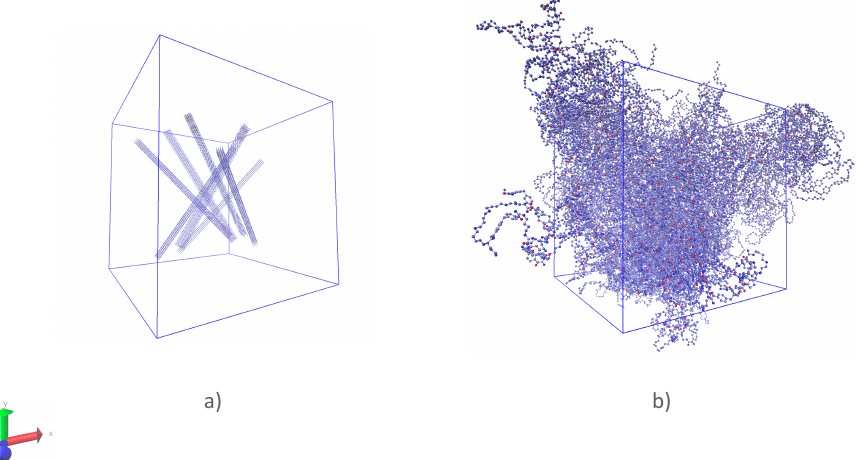
Figure 3. ( a ) Chains of TPU randomly distributed in the periodic supercell; ( b ) structure of TPU before calculation of the thermal